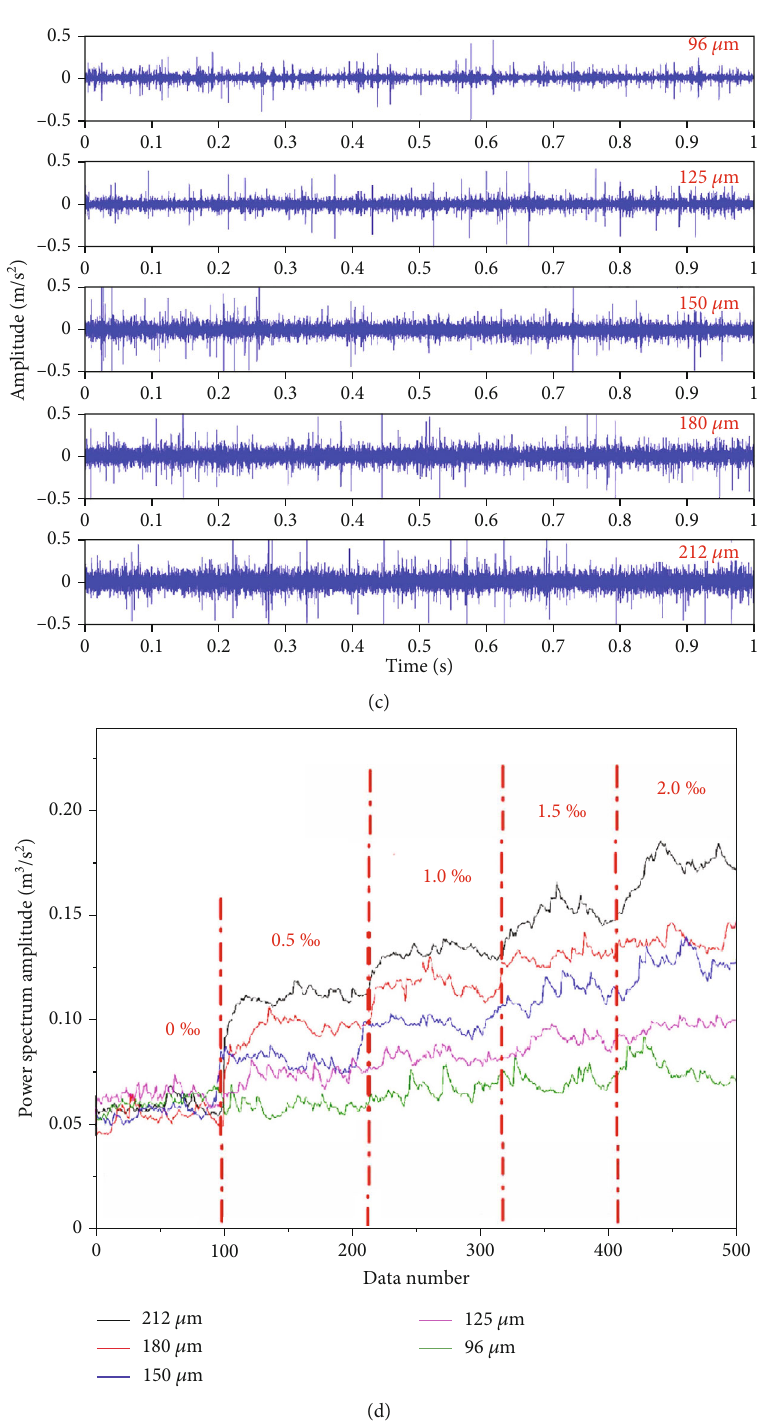
Figure 4: Analysis of the signal characteristics of sand production under di ff erent particle size conditions (sand content 1 ‰ , fl ow velocity 1.5m/s): (a) frequency domain diagram; (b) time spectrum; (c) 30-50 kHz time domain diagram; (d) power spectrum